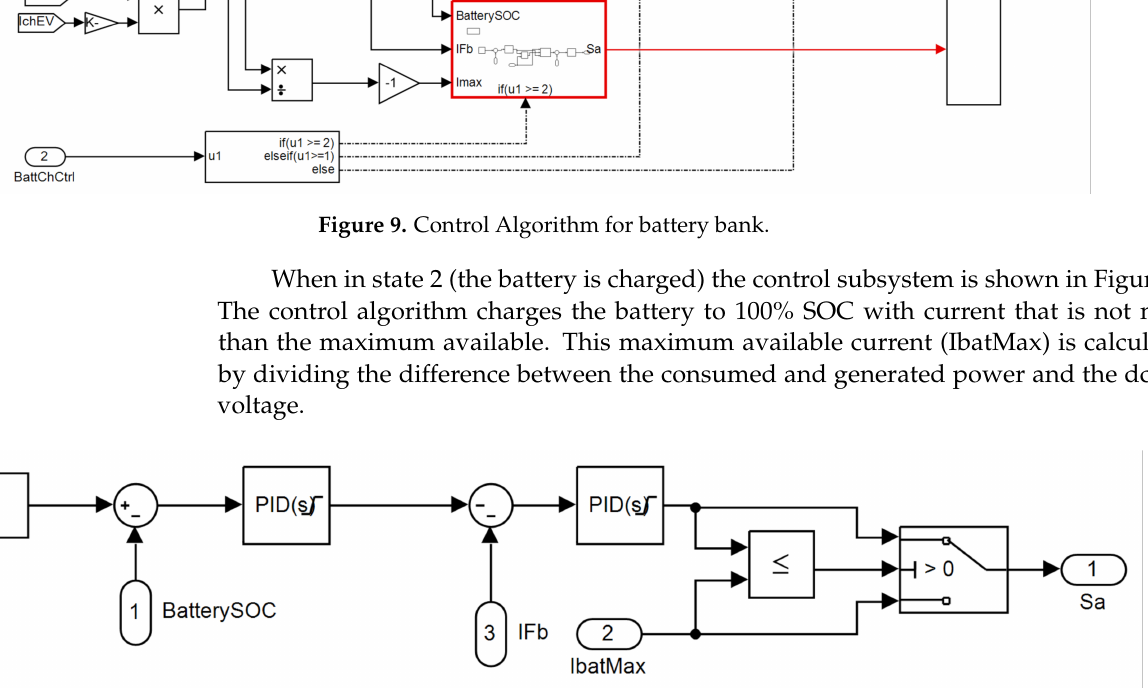
Figure 10. Control algorithm when charging the battery